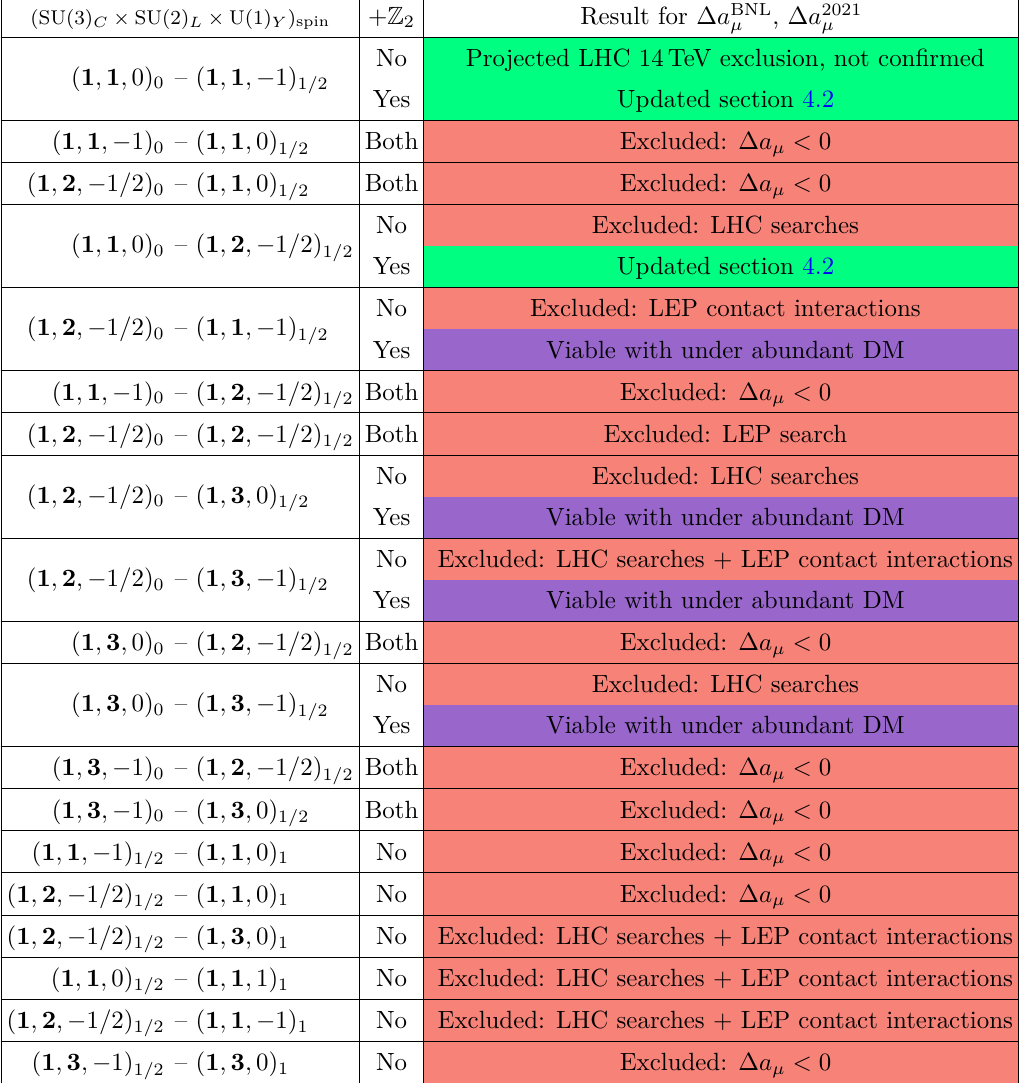
Table 2. Summary of known results for gauge invariant extensions of two fields with different spin with one-loop contributions to the anomalous magnetic moment of the muon. These results